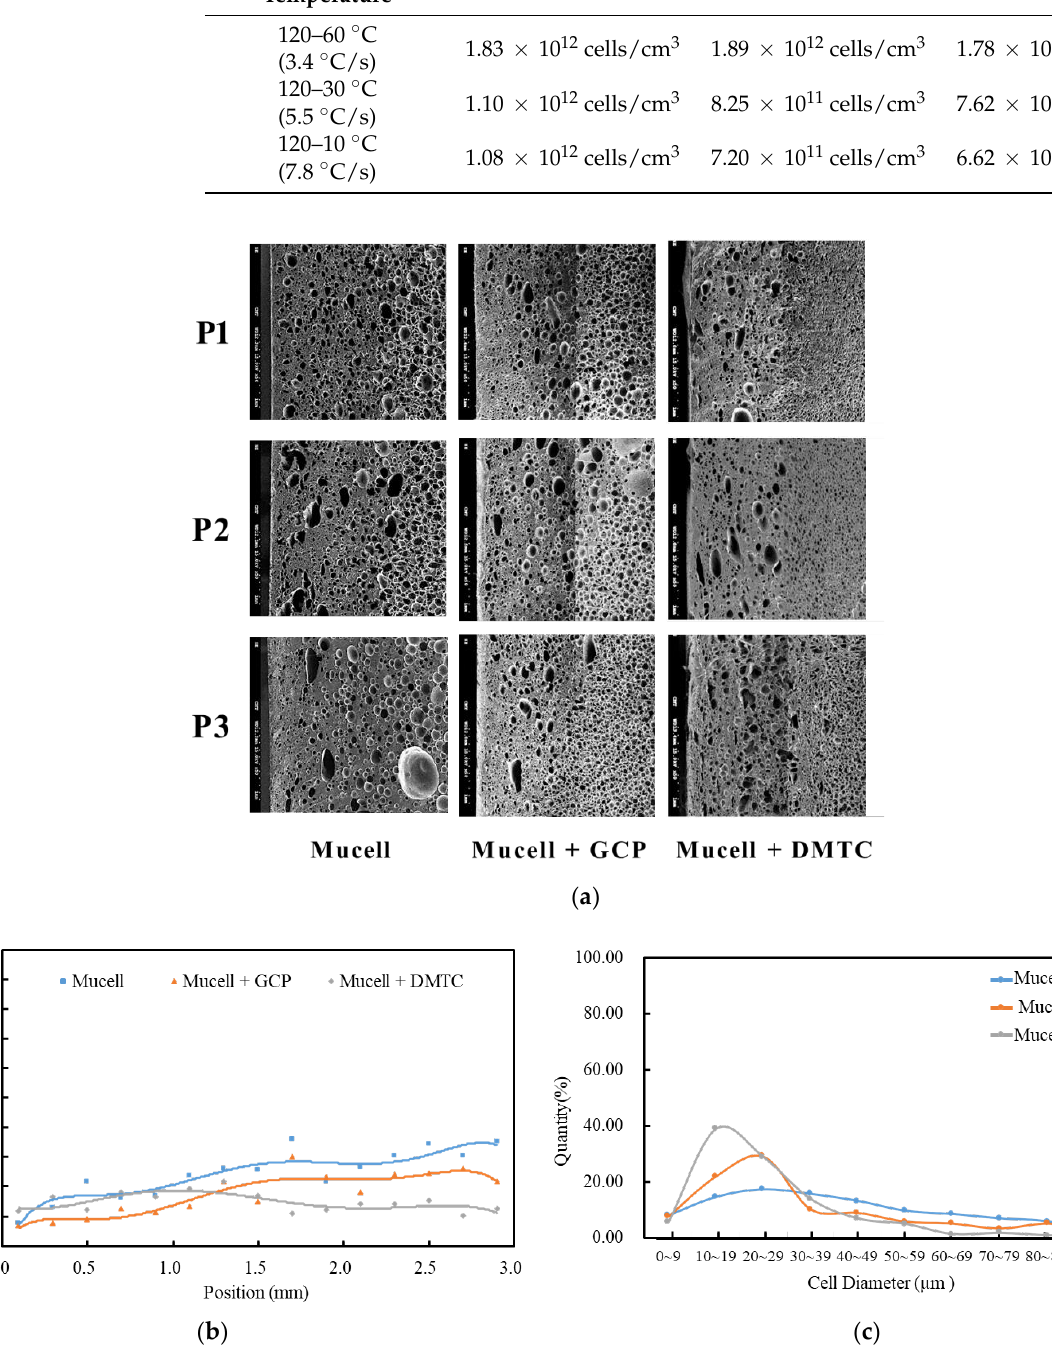
Figure 10. Comparison of foaming morphology among traditional MuCell ® , MuCell plus GCP and MuCell plus DMTC. ( a ) SEM photograph. ( b ) Cell diameter across the section at P1. ( c ) Cell-diameter distribution at P1. Table 9. Averaged cell density at different DMTC situations (cooling rate).